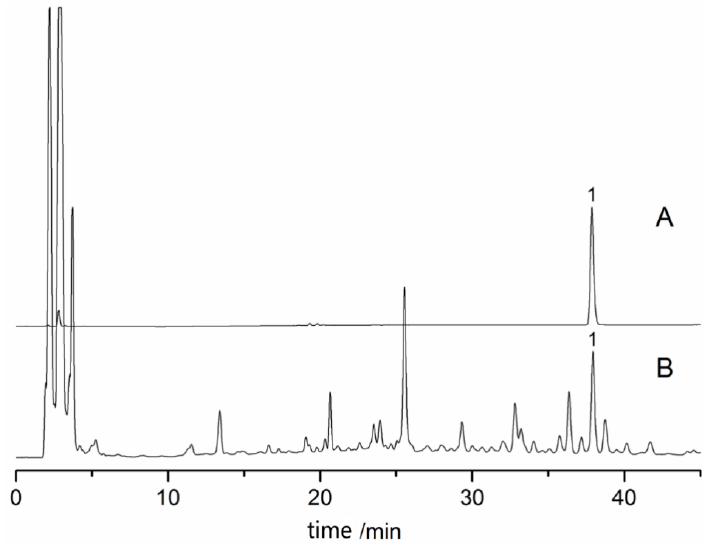
Figure 3. HPLC chromatogram of Shengmaxinside I content from Rhizoma Cimicifugae.